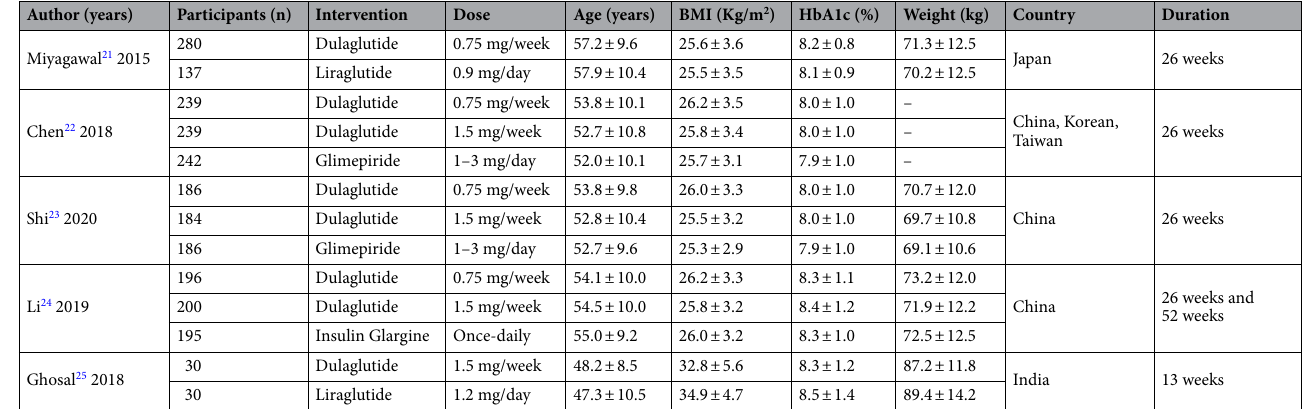
Table 1. General characteristics of included